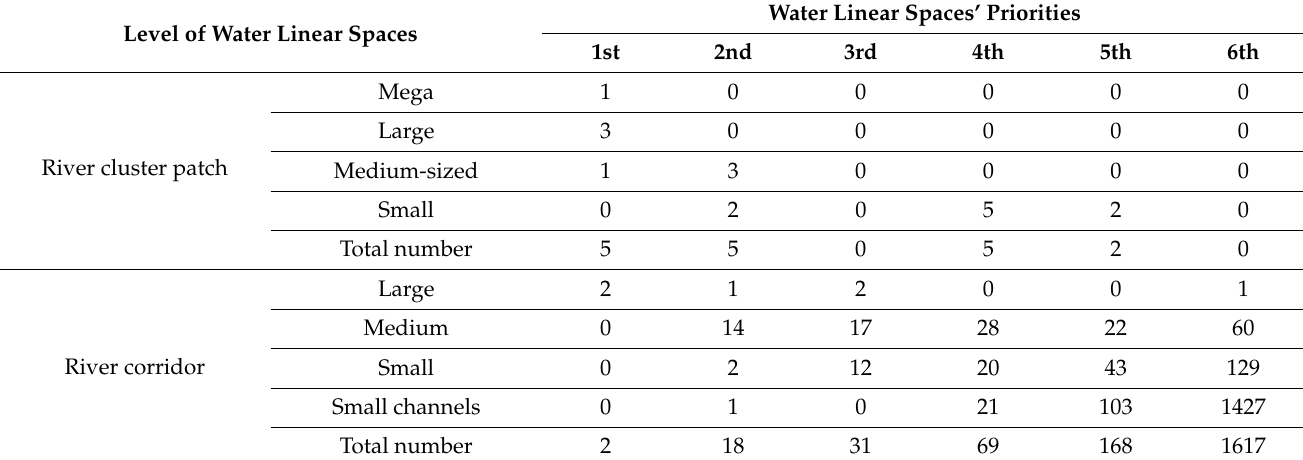
Table A8. Statistical results of two configurations of water linear spaces in six